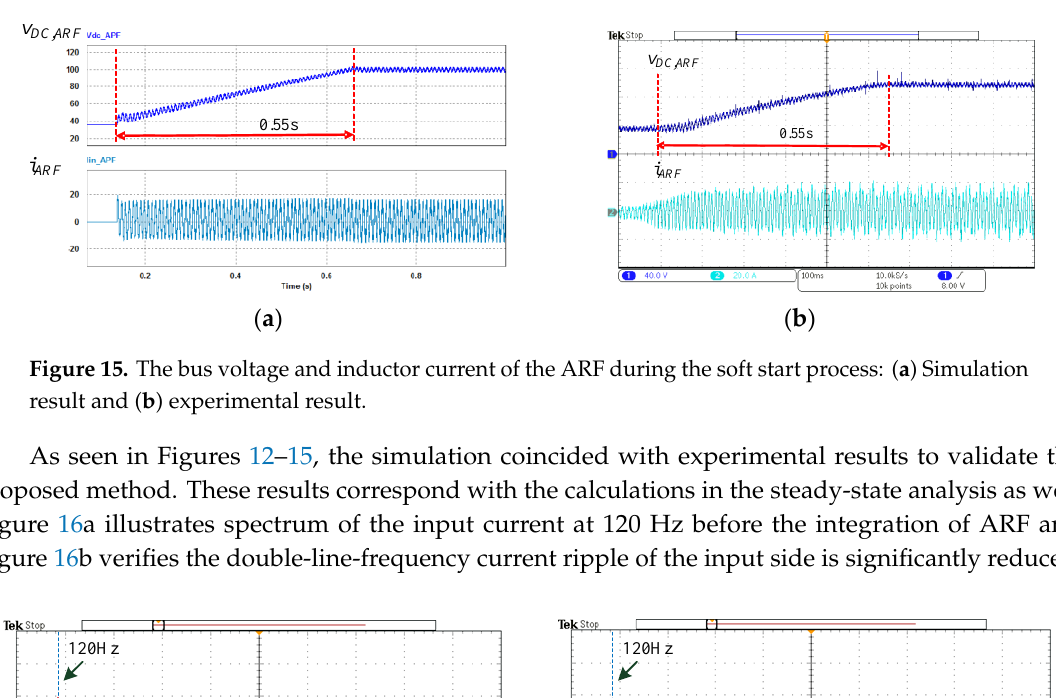
( b ) Figure 14. The output voltage and current of the proposed single-phase DC/AC conversion system.